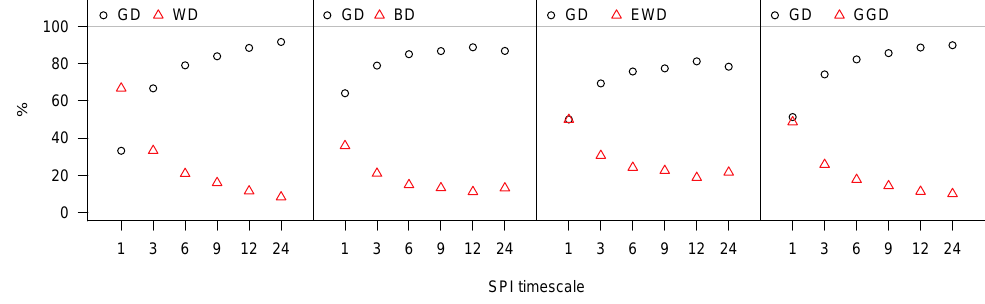
equal zero for the European region. The GD (black dots) is compared to the WD, BD, EWD and GGD (red